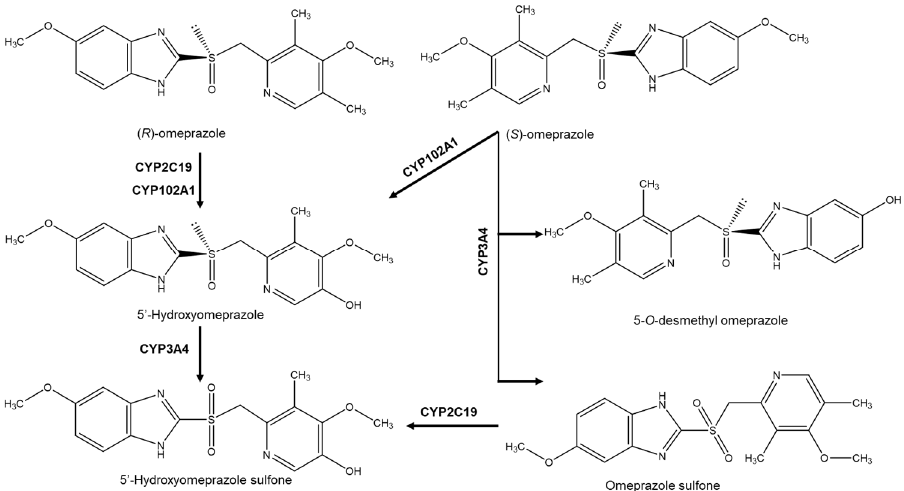
Figure 2. Omeprazole enantiomers metabolism.